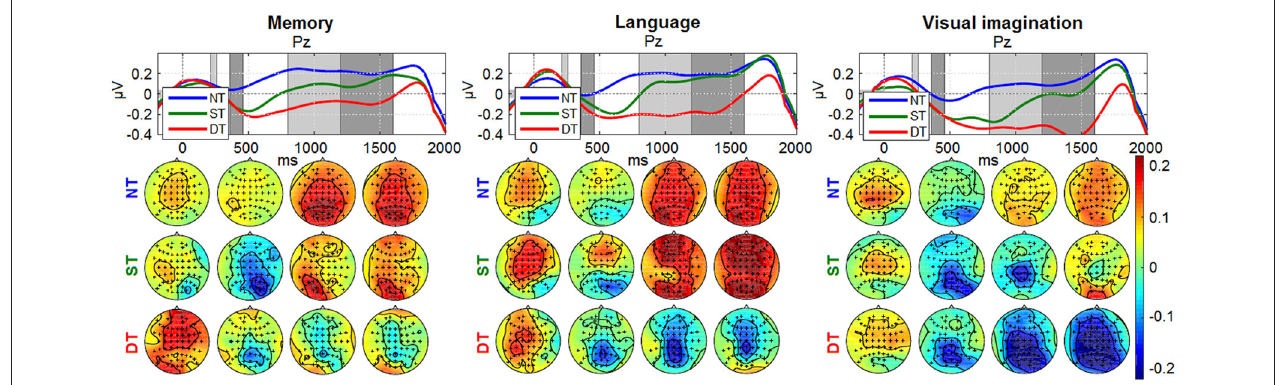
FIGURE 9 | Grand-average ERDs on 16–20 Hz at electrode Pz for all processing levels (NT, ST, DT) with 200 ms baseline. Same amplitude range for all conditions , as − 0.4 to 0.4 µ V for time evolution and − 0.22 to 0.22 µ V for scalp distributions.